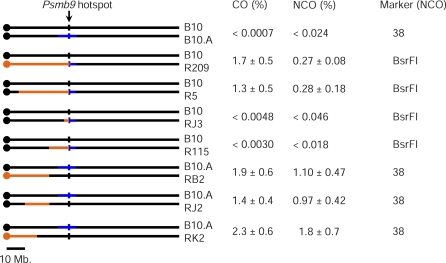
CO and NCO Events at Psmb9 Are Activated by a Long Distance–Acting Element from the wm7 HaplotypeThe origin of the Chr 17 fragments in the different recombined lines is represented: black, B10 (B10 or B6 for R115) (haplotype b); blue, A (haplotype a); and orange, SGR (haplotype wm7). The 95% confidence intervals for recombinant product frequencies are calculated as described in [38]. NCOs were detected either at the BsrFI site or the site “38,” depending on which is heterozygous in each hybrid. Values for B10xB10.A and B10xR209 are from [38].